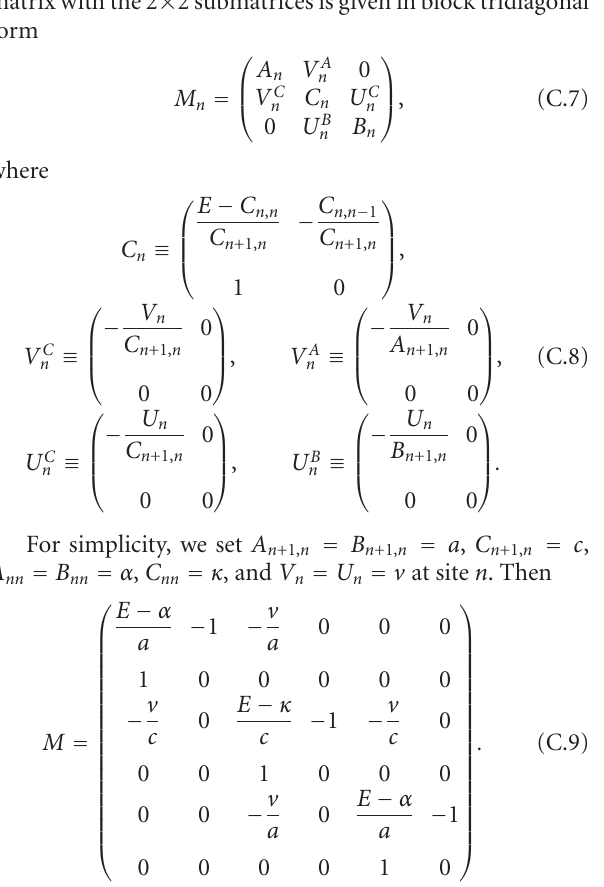
system of coupled three chains: Φ n +1 = M n Φ n , where Φ n